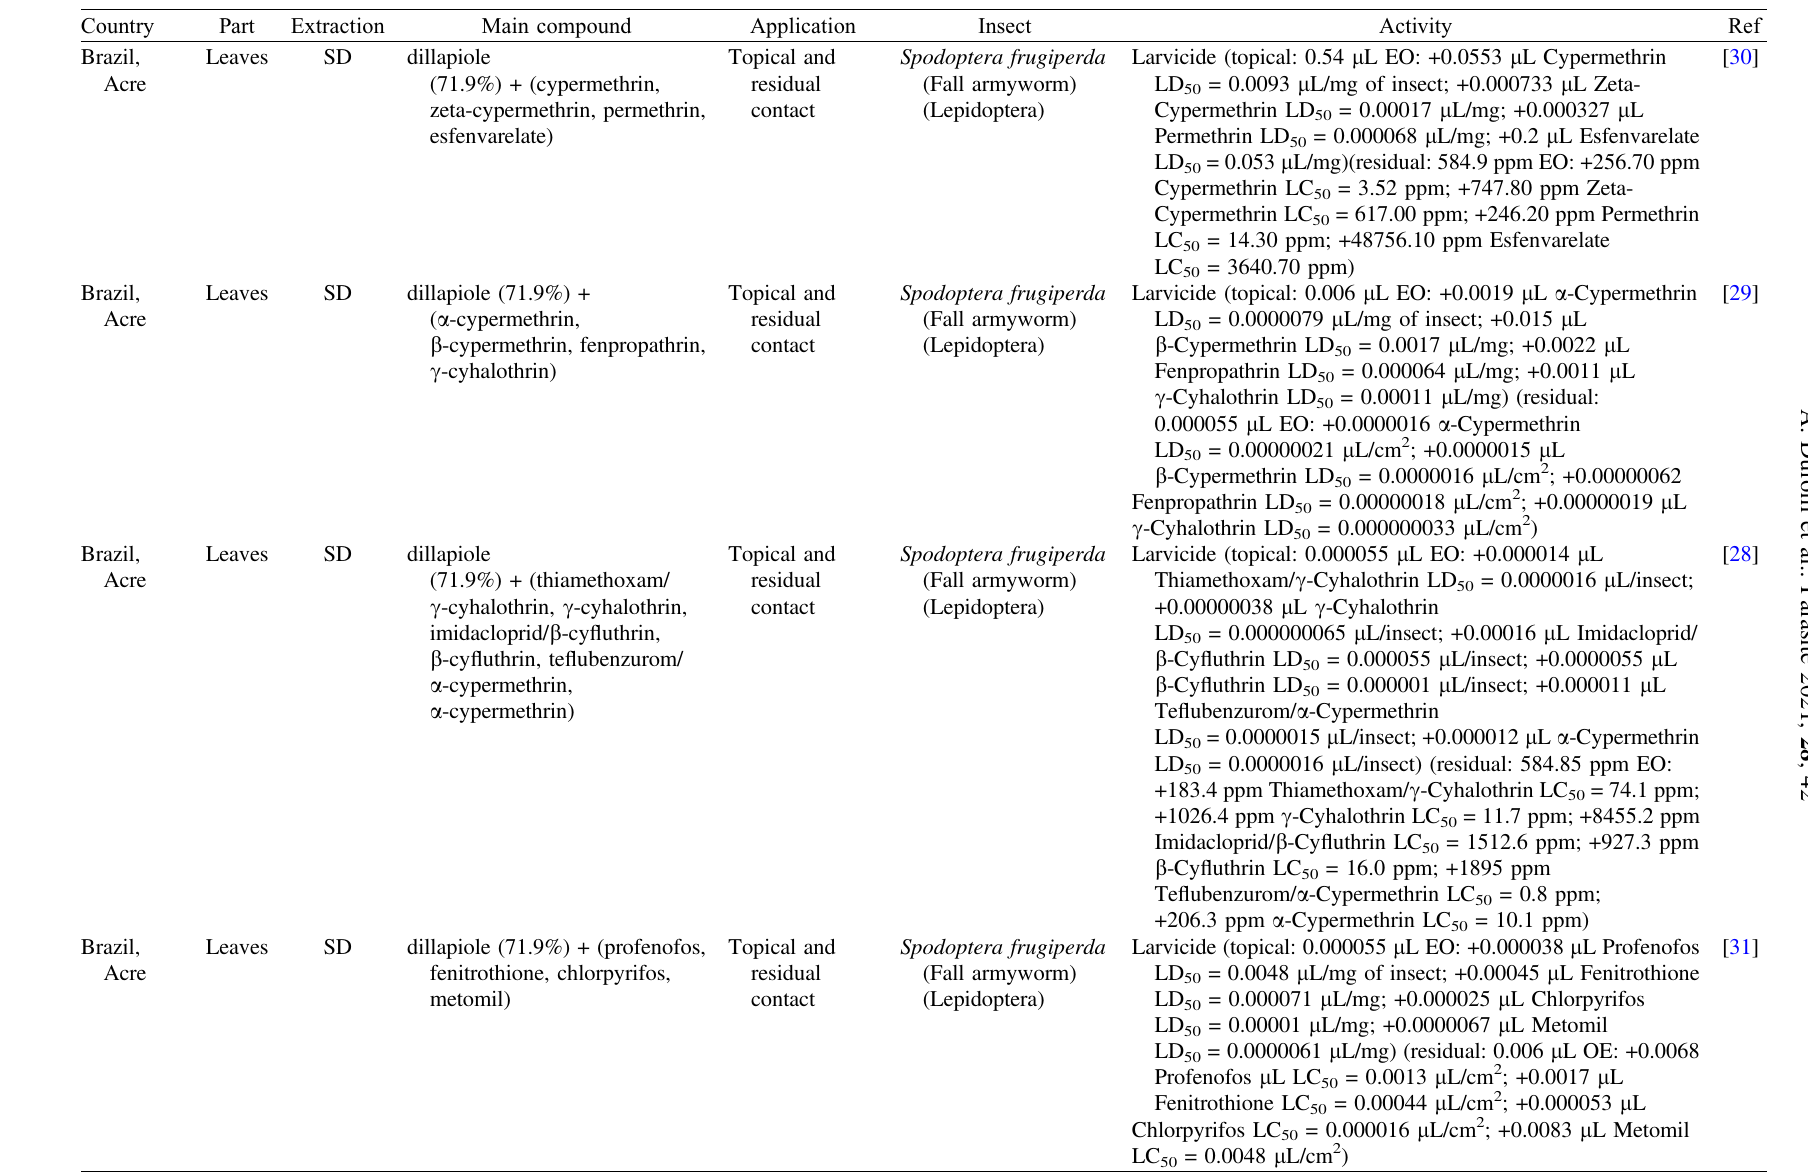
Table 5. Synergetic properties of dillapiole along with chemical insecticides.